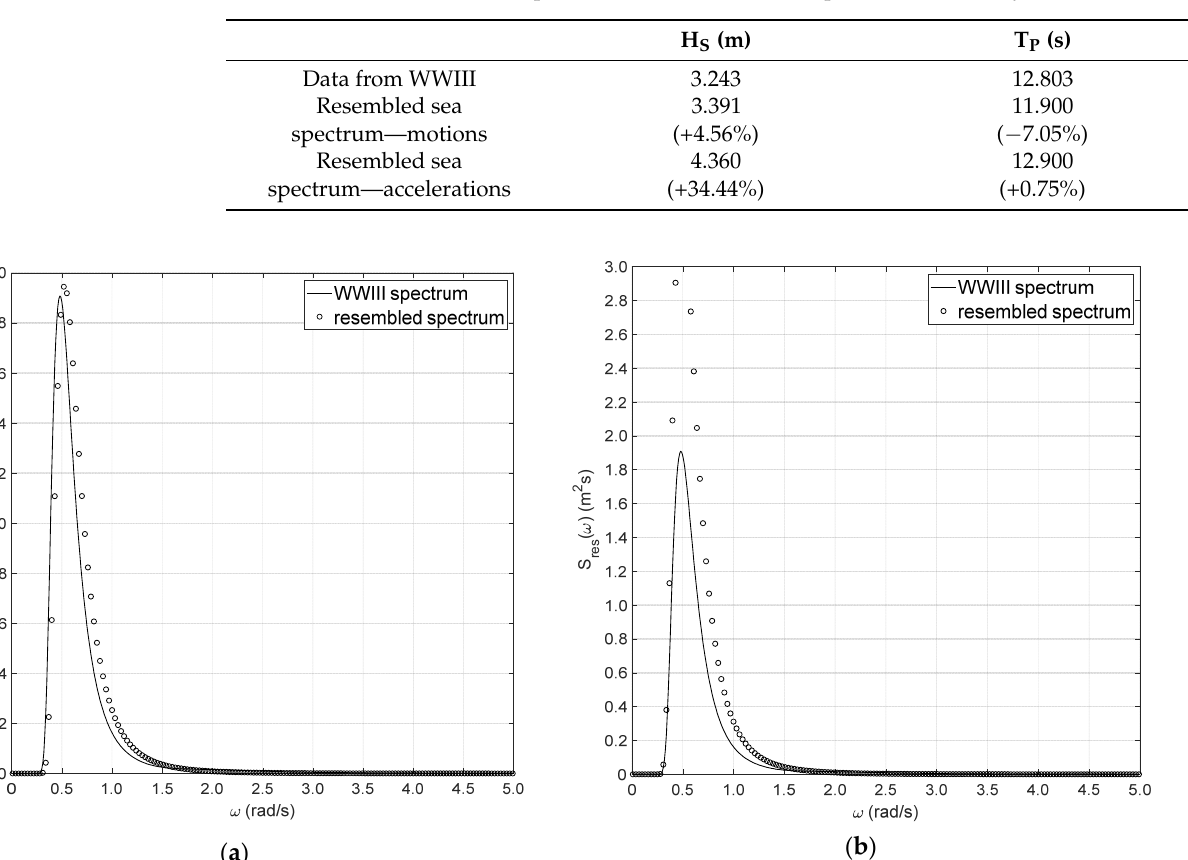
Table 4. Parameters of rebuilt spectrum for a combined sea spectrum—8 January 2020.